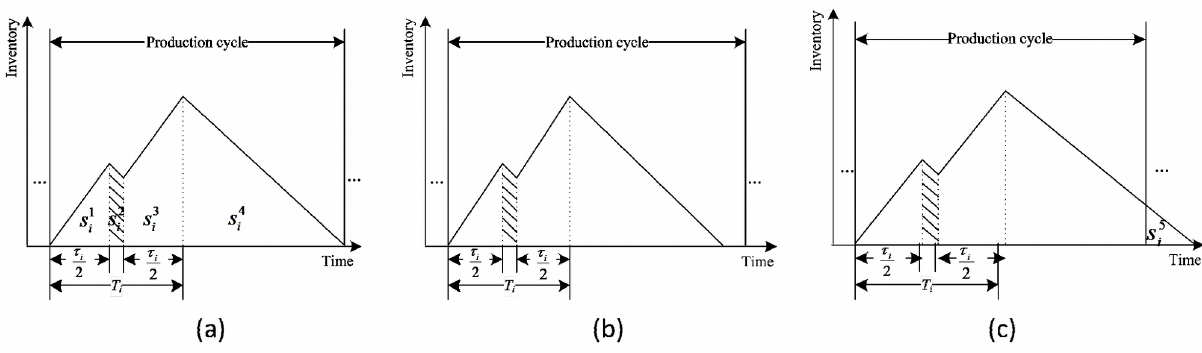
Figure 1. The inventory scenarios of product i